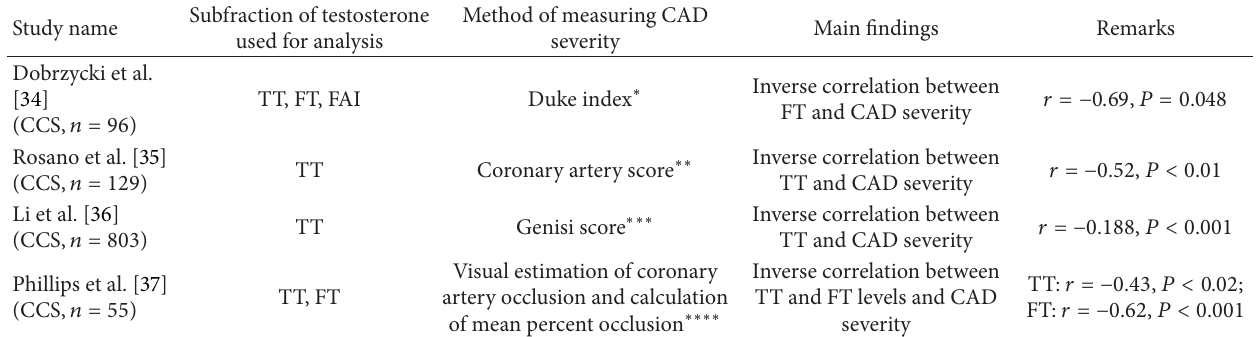
Table 2: Association between testosterone level and severity of coronary artery